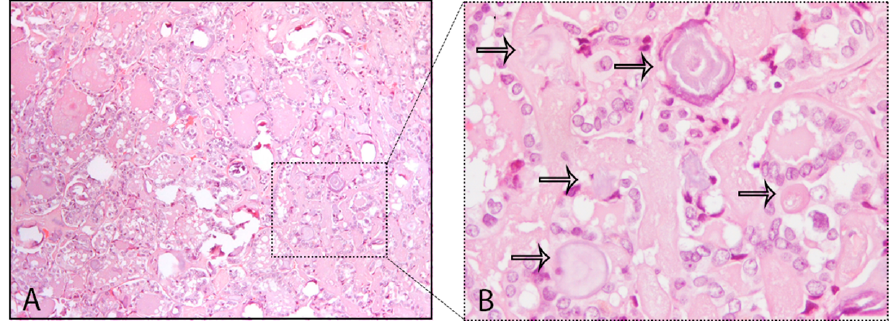
Figure 2. Psammoma bodies (PBs) in a papillary thyroid carcinoma: ( A ) visible PBs with purple color in hematoxylin and eosin (HE) staining, 10×; ( B ) magnified inset with PBs marked with the black arrows, 40×.